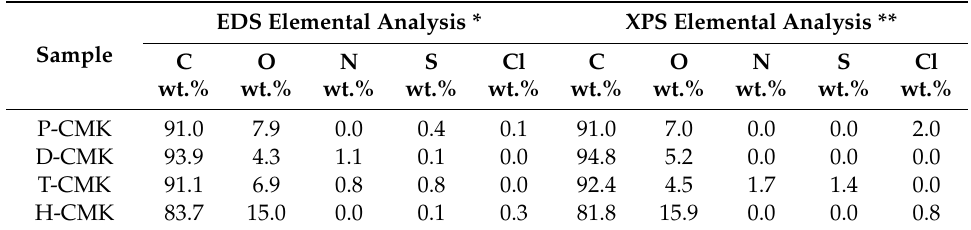
Table 2. Elemental analysis of the samples studied as given by EDS and XPS methods. EDS Elemental Analysis Sample